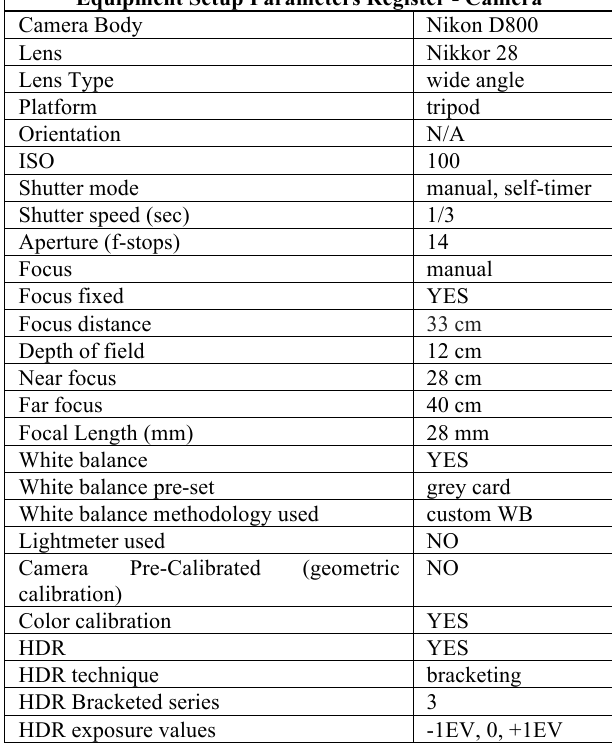
Table 1. Form filled for Equipment Setup Parameters Register -